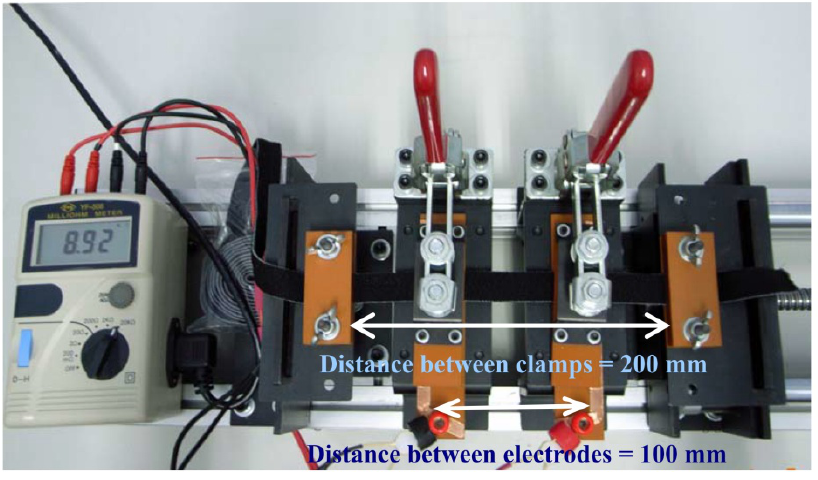
Figure 2. A self-assembled apparatus for measuring the